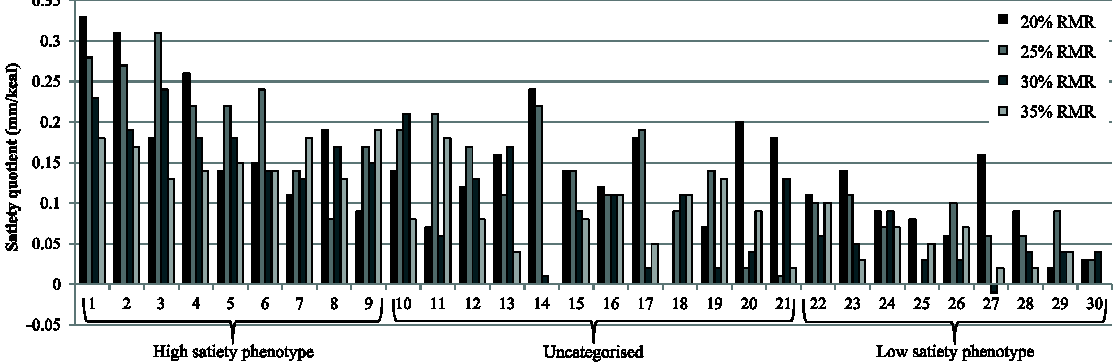
Figure A1. Individual variability in SQ in the 20%, 25%, 30% and 35% resting metabolic rate (RMR) conditions.